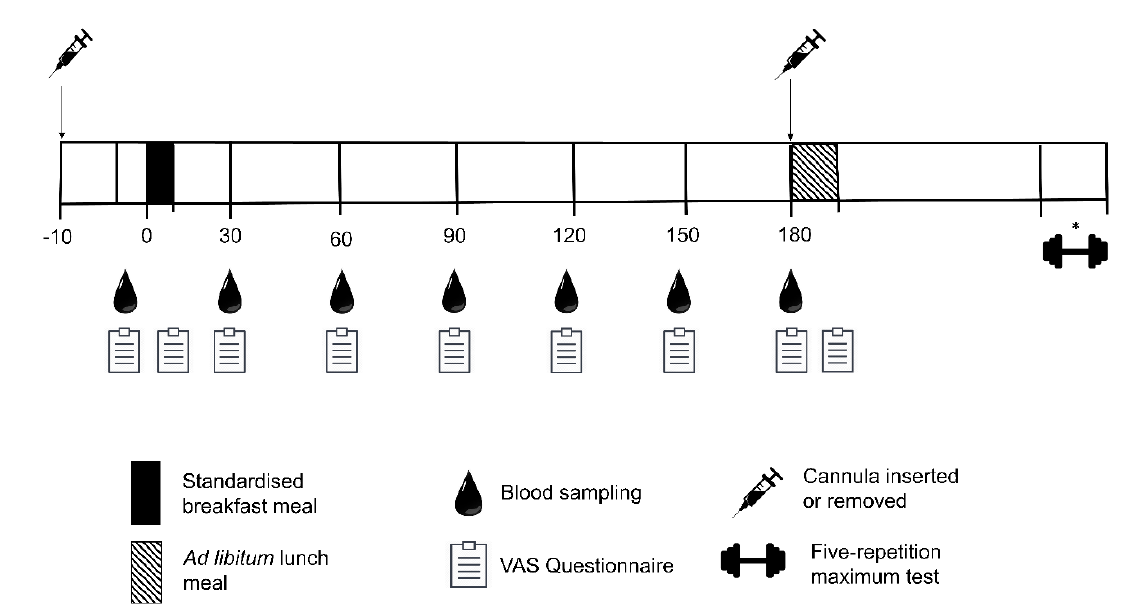
Figure 3. Schematic representation of meal tolerance test conducted at baseline, week 6 and 12. * Indicates procedures that were taken during baseline and Week 12 only. VAS; visual analogue scale.